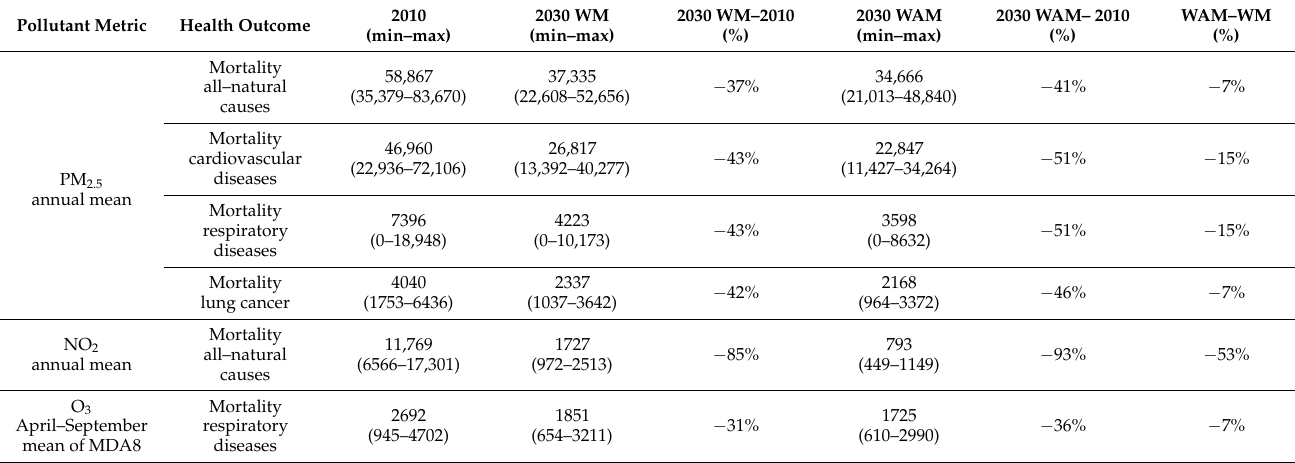
Table 8. National-level mortality (number of